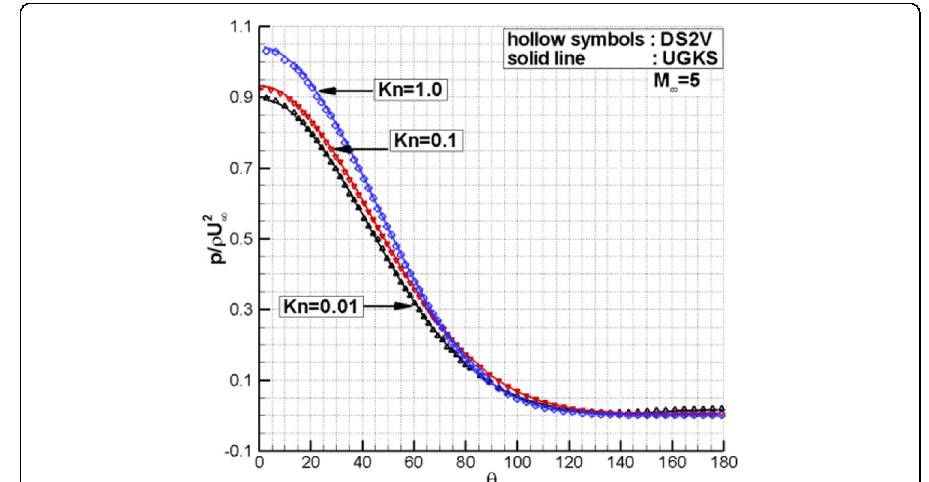
Fig. 16 Pressure distributions on the cylinder surface at M =